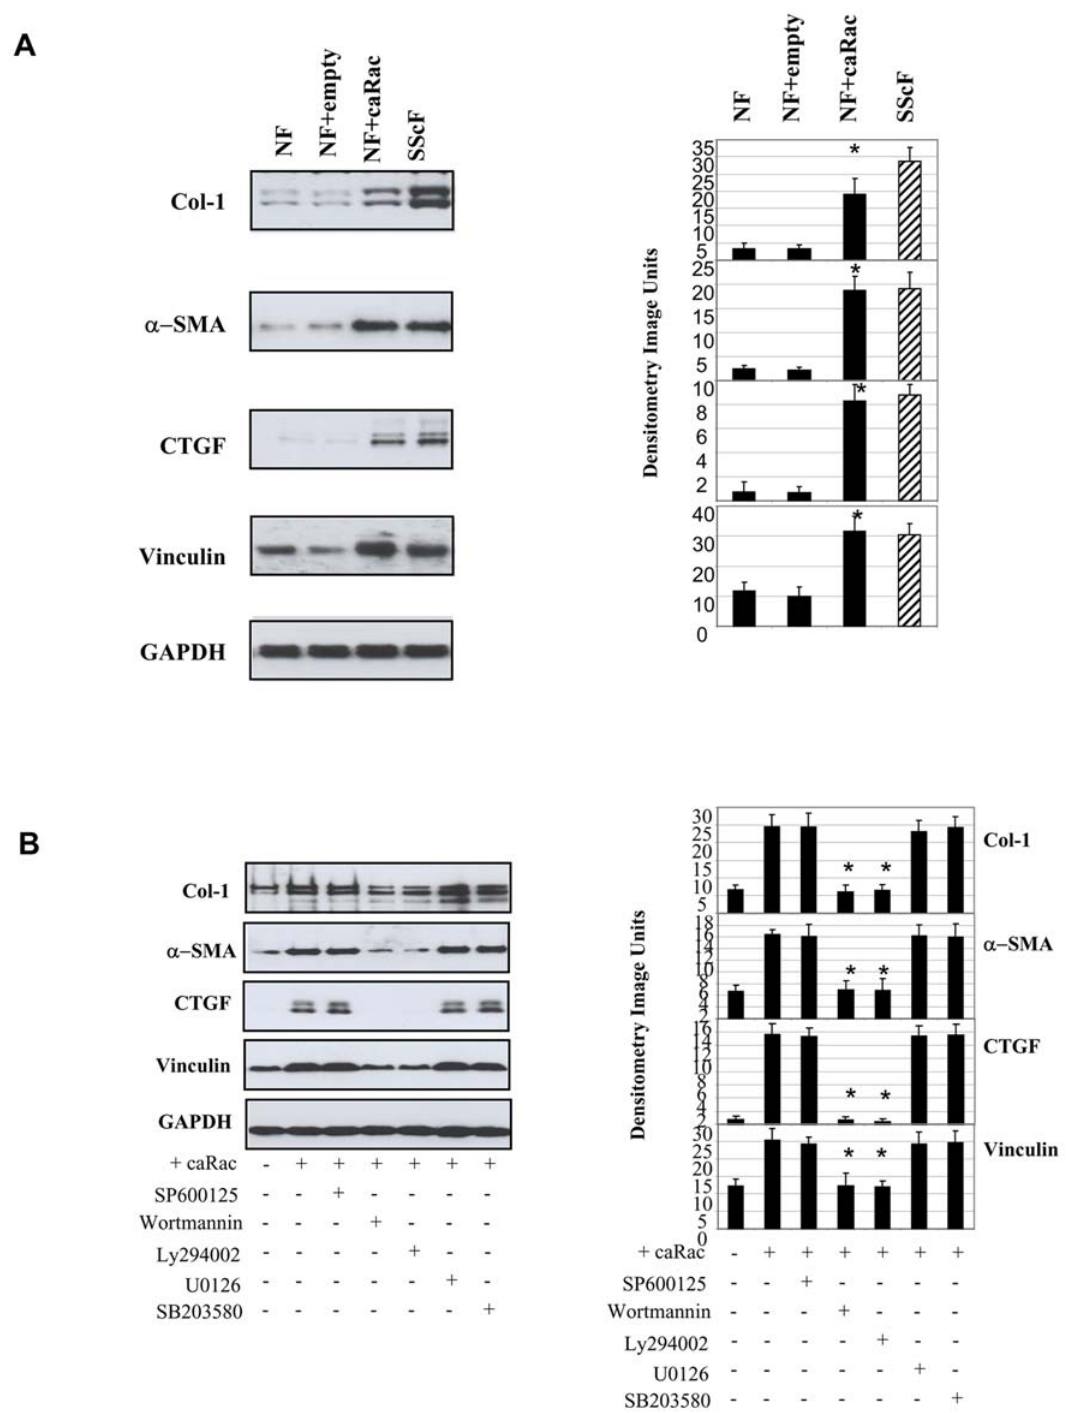
Figure 5. Overexpression of rac in normal fibroblasts results in a profibrotic phenotype in a PI3kinase/Akt-dependent fashion: protein analysis. (A) Transfection of constitutively active rac (ca rac), compared to empty expression vector (empty), increases profibrotic protein expression. Twenty four hours post-transfection, protein was harvested and subjected to Western blot analysis was conducted with antibodies detecting the proteins indicated. Average + / 2 standard deviation is shown (N=3, *=p , 0.05). (B) The effect of rac overexpression is reduced by PI3 kinase inhibition. Cells were transfected with empty expression vector or constitutively active rac (ca rac) in the presence or absence of 100 nM wortmannin, 10 m M Ly294002, 10 m M U0126 and 10 m M SP600125. Cells were then processed for Western blot analysis as described in (A).